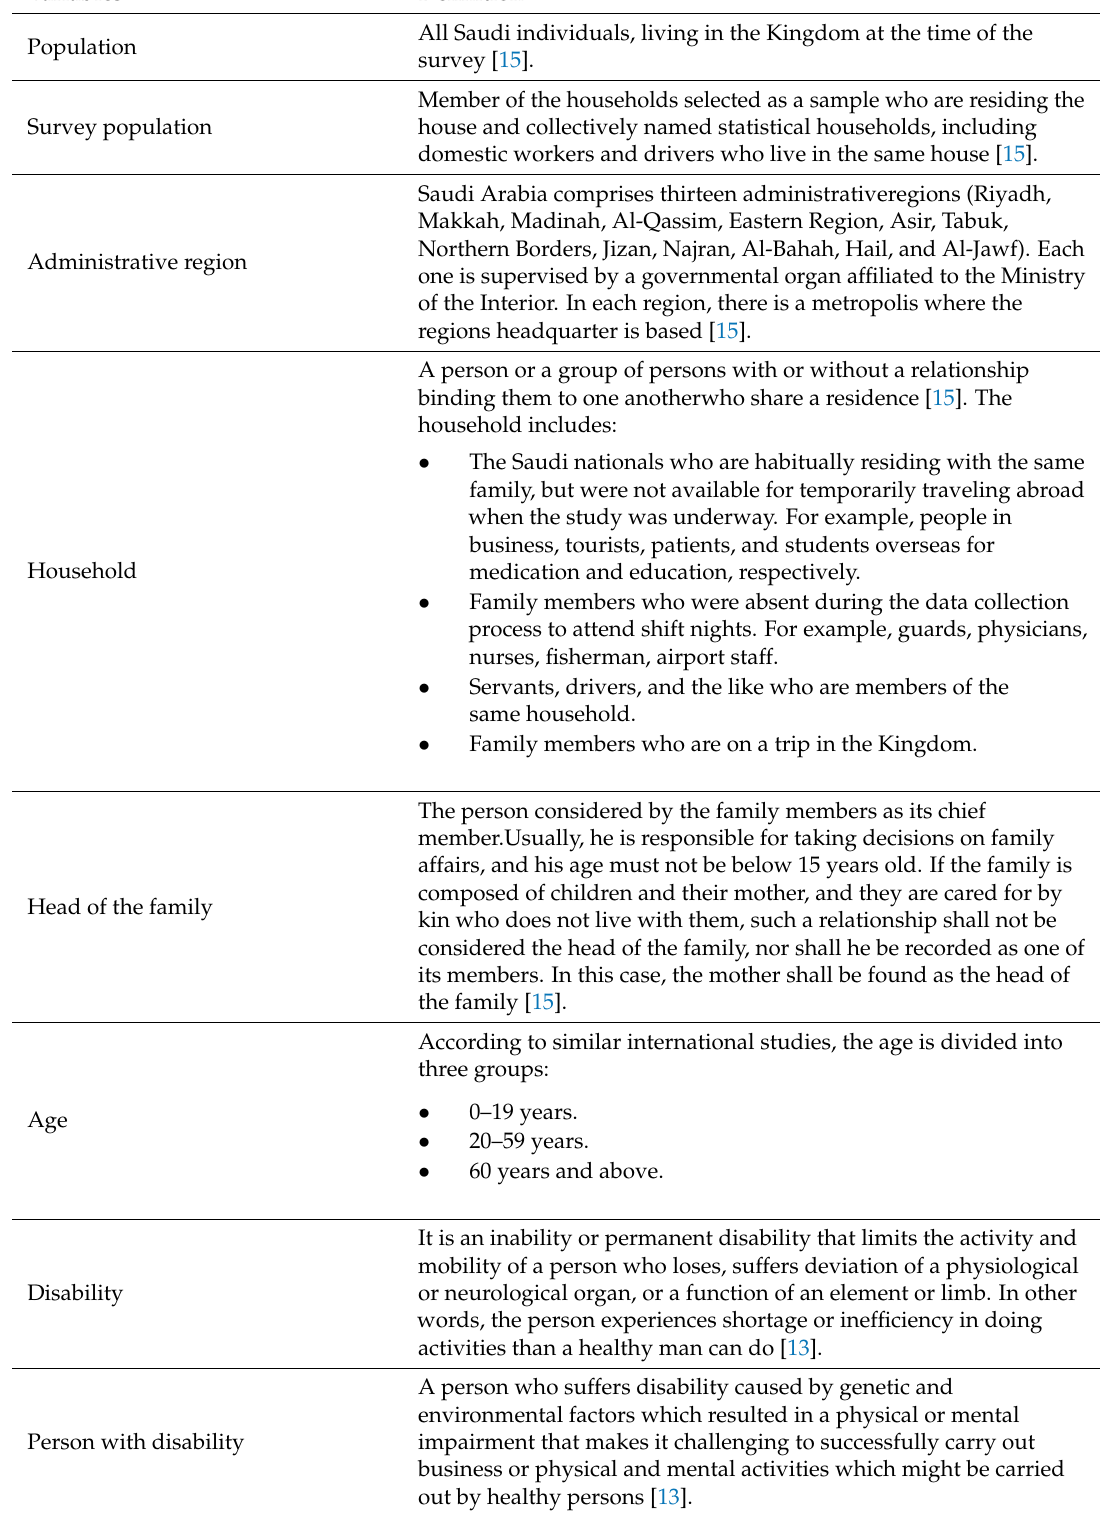
Table 1. Definition of the variables used in the demographic survey of 2016 in Saudi Arabia.